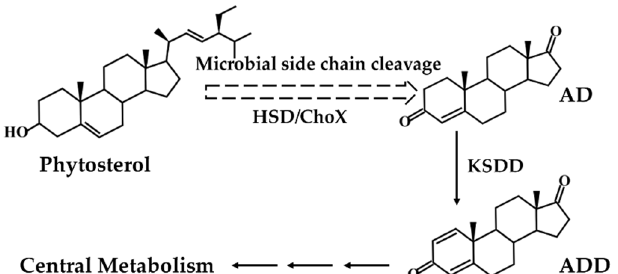
Figure 1. Microbial transformation pathway of phytosterols to androst-1,4-diene-3,17-dione (ADD).